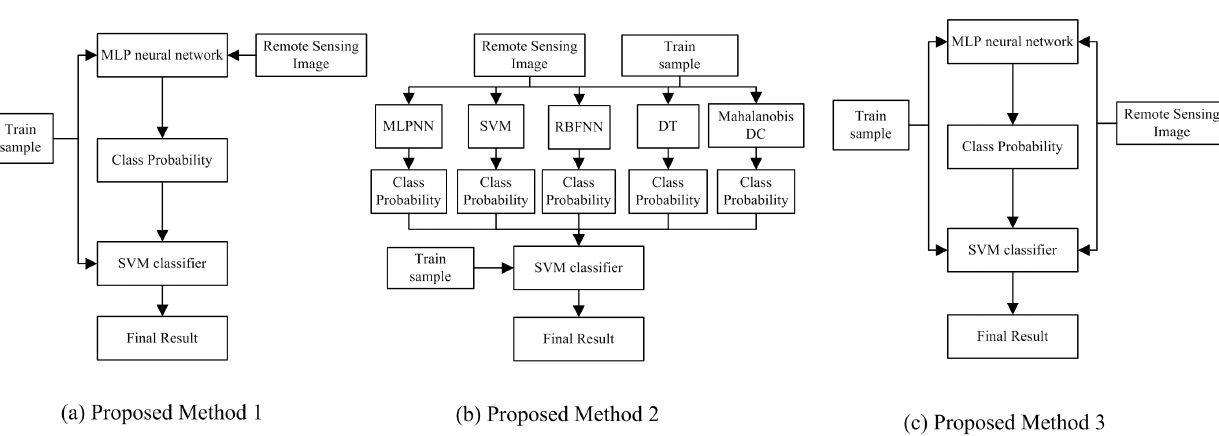
Figure 3. The structure of concatenation